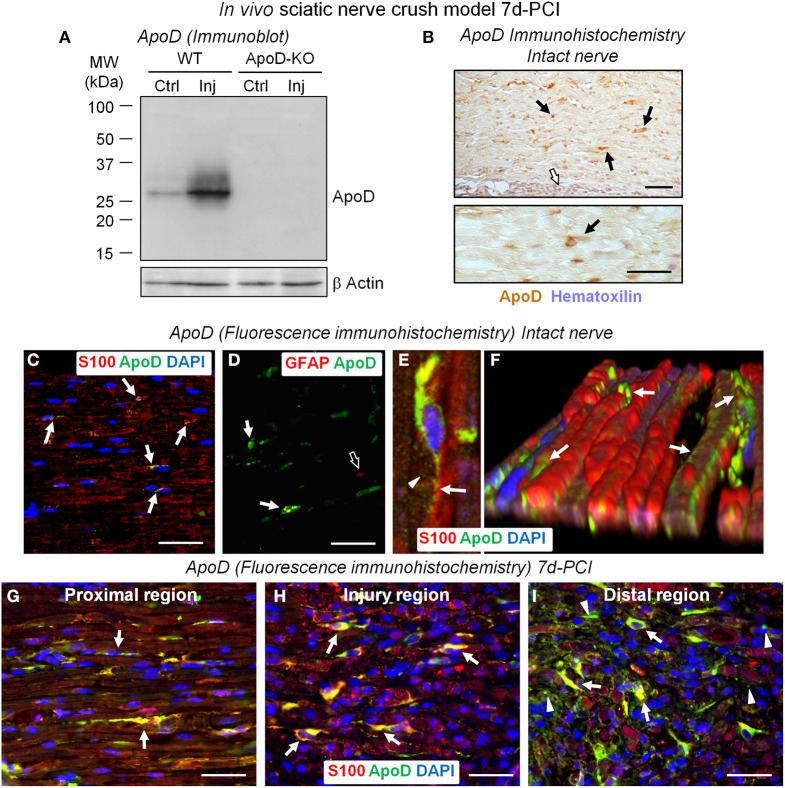
ApoD is over-expressed by Schwann cells at 7 days after sciatic nerve crush injury. (A) Immunoblot analysis of ApoD in the region distal to the nerve lesion of WT and ApoD-KO mice. High levels of ApoD protein are observed 7d-PCI. (B) HRP-immunohistochemistry of ApoD in sagittal sections of intact sciatic nerves. Scattered ApoD-positive cells are seen in the endoneurium (arrows), while no labeling is seen in the perineurium (white arrow). (C–F) Fluorescence-immunohistochemical detection of ApoD in sagittal sections of intact sciatic nerves. Co-localization of ApoD and S100 (arrows in C) confirms Schwann cells (SCs) as a source of ApoD in sciatic nerves. A subset of non-myelinating SCs also expresses ApoD as evidenced by co-localization with the GFAP marker (arrows in D) compared to GFAP-only signal (open arrow in D). Confocal image (E) and a 3-D reconstruction of a Z-stack of confocal images (F) of fluorescence immunohistochemistry show ApoD labeling in secretion vesicles (arrowhead in E) and the SCs outer sheath (arrows in E,F). (G–I) Co-localization of ApoD and the SC marker S100 in sagittal sections of a crushed WT sciatic nerve 7d-PCI at different positions with respect to the injury site. Arrows point to ApoD labeling in intact and denervated SCs. Arrowheads in (I) (region distal to the crush) show ApoD adjacent to S100-positive myelin debris. Calibration bars: 50 μm.